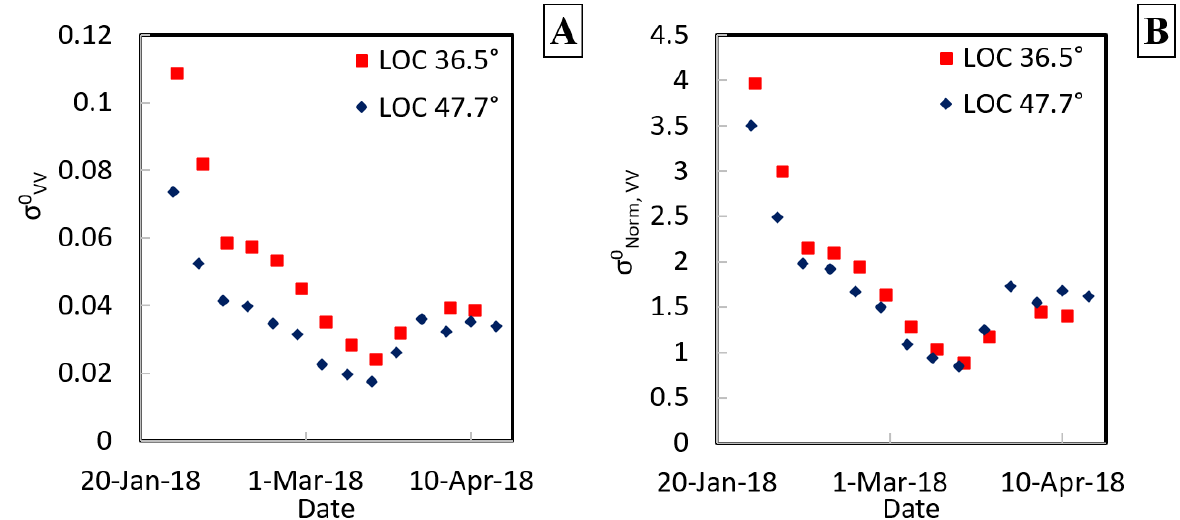
Figure 6. A time series of VV polarization values recorded by Sentinel-1 on its ascending overpasses with local incidence angles of 36.5° and 47.7° during the wheat experiment in Saad: ( A ) prior to applying the σ 0 normalization; ( B ) post-normalization. Table 3. R 2 and RMSE improvements following the local incidence angle normalization procedure. Significance is marked by *. The percentage values in the brackets show improvement in RMSE after normalization (i.e., the reduction in prediction